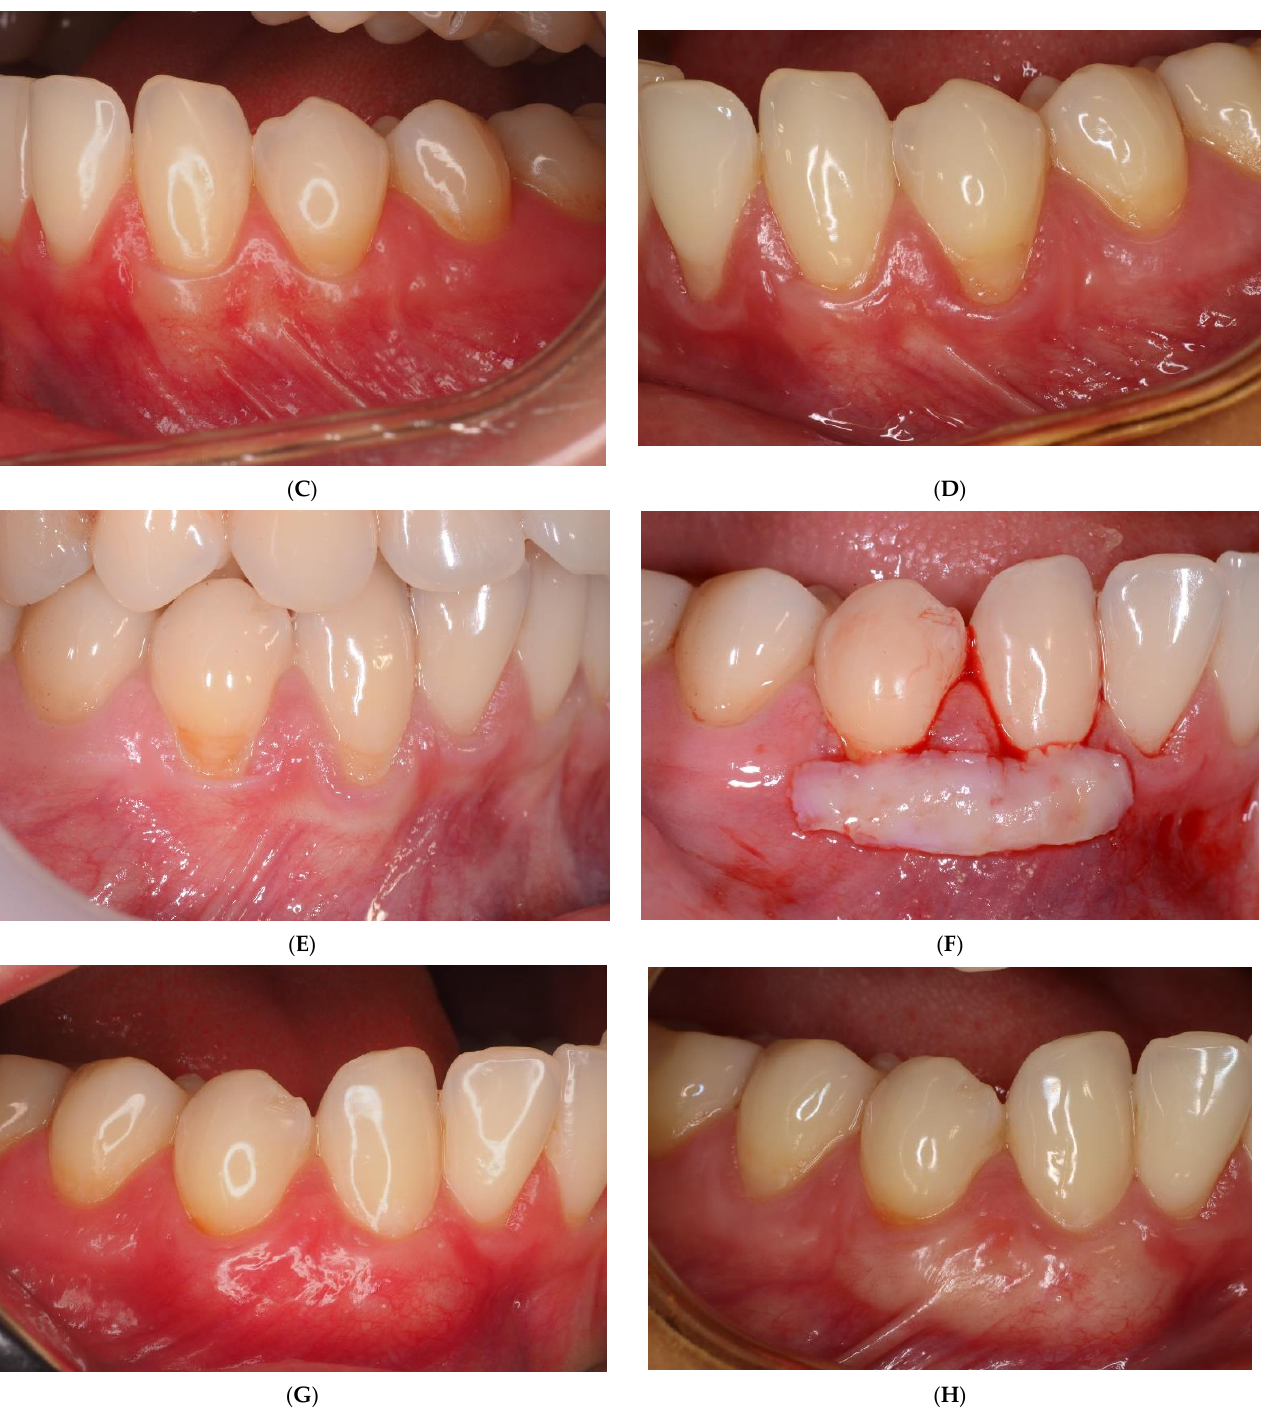
Figure 2. ( A ) Baseline CM side: the canine and the first premolar with recessions on the left side in the lower jaw; ( B ) CM position; ( C ) postoperative (12 months) view; ( D ) postoperative (5 years) view; ( E ) baseline SCTG side: the canine and the first premolar with recessions on the right side in the lower jaw; ( F ) SCTG position; ( G ) postoperative (12 months) view; ( H ) postoperative (5 years) view.